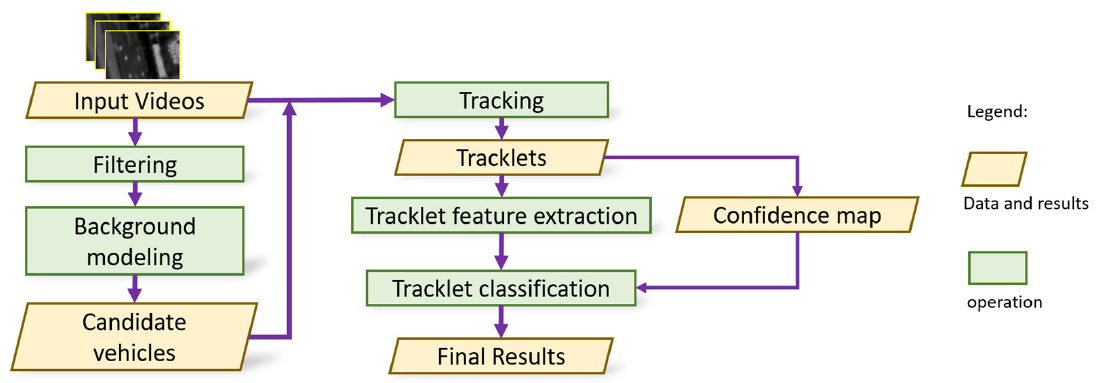
Figure 1. The flow of the proposed method.